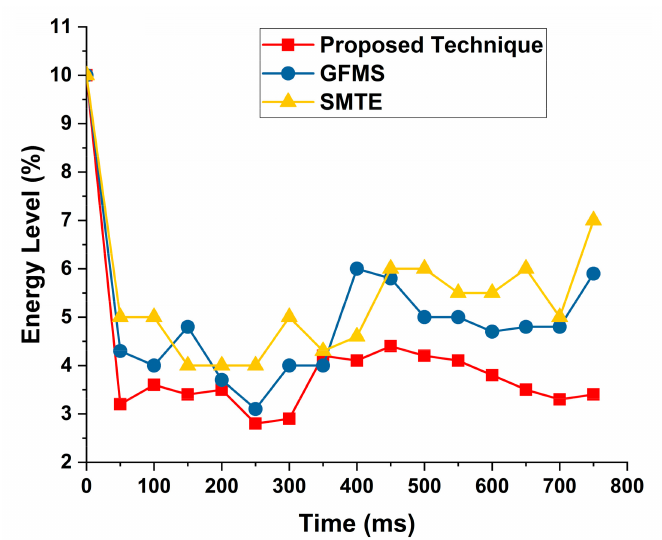
Figure 13. Task energy level consumption while task offloading to MCC